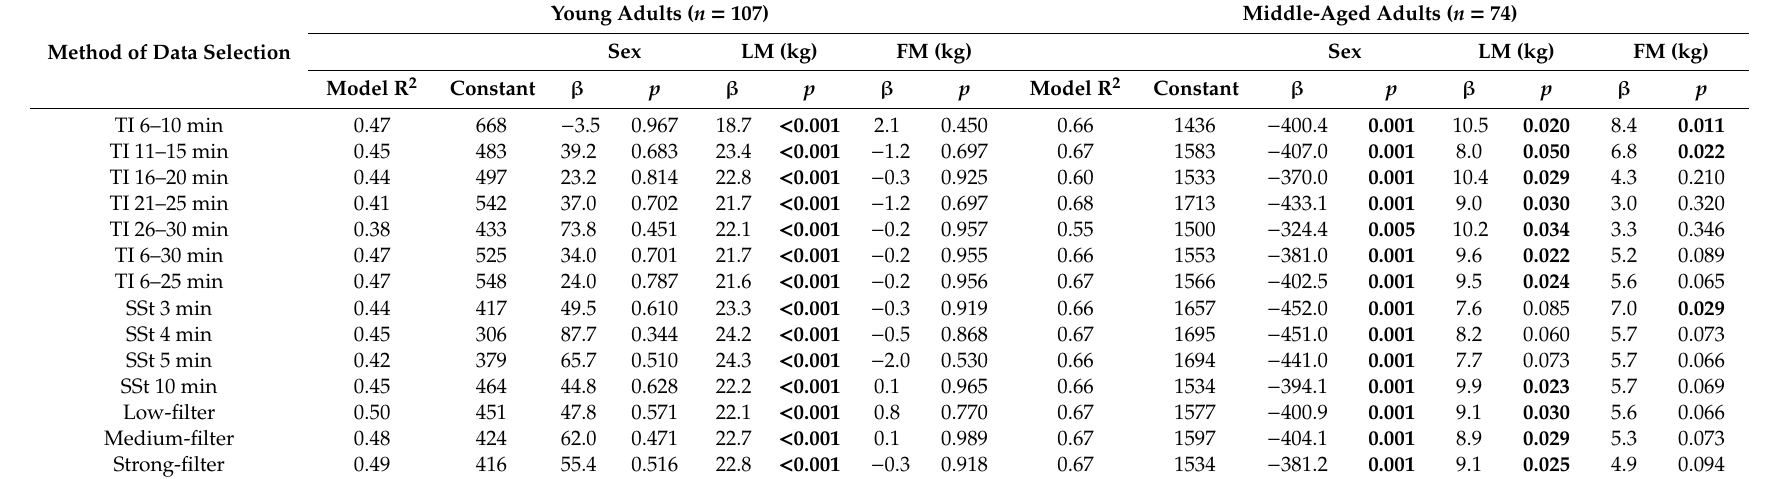
Table 3. Variance in resting metabolic rate (RMR) explained by sex, lean mass (LM) and fat mass (FM) in each of the gas exchange data selection methods.